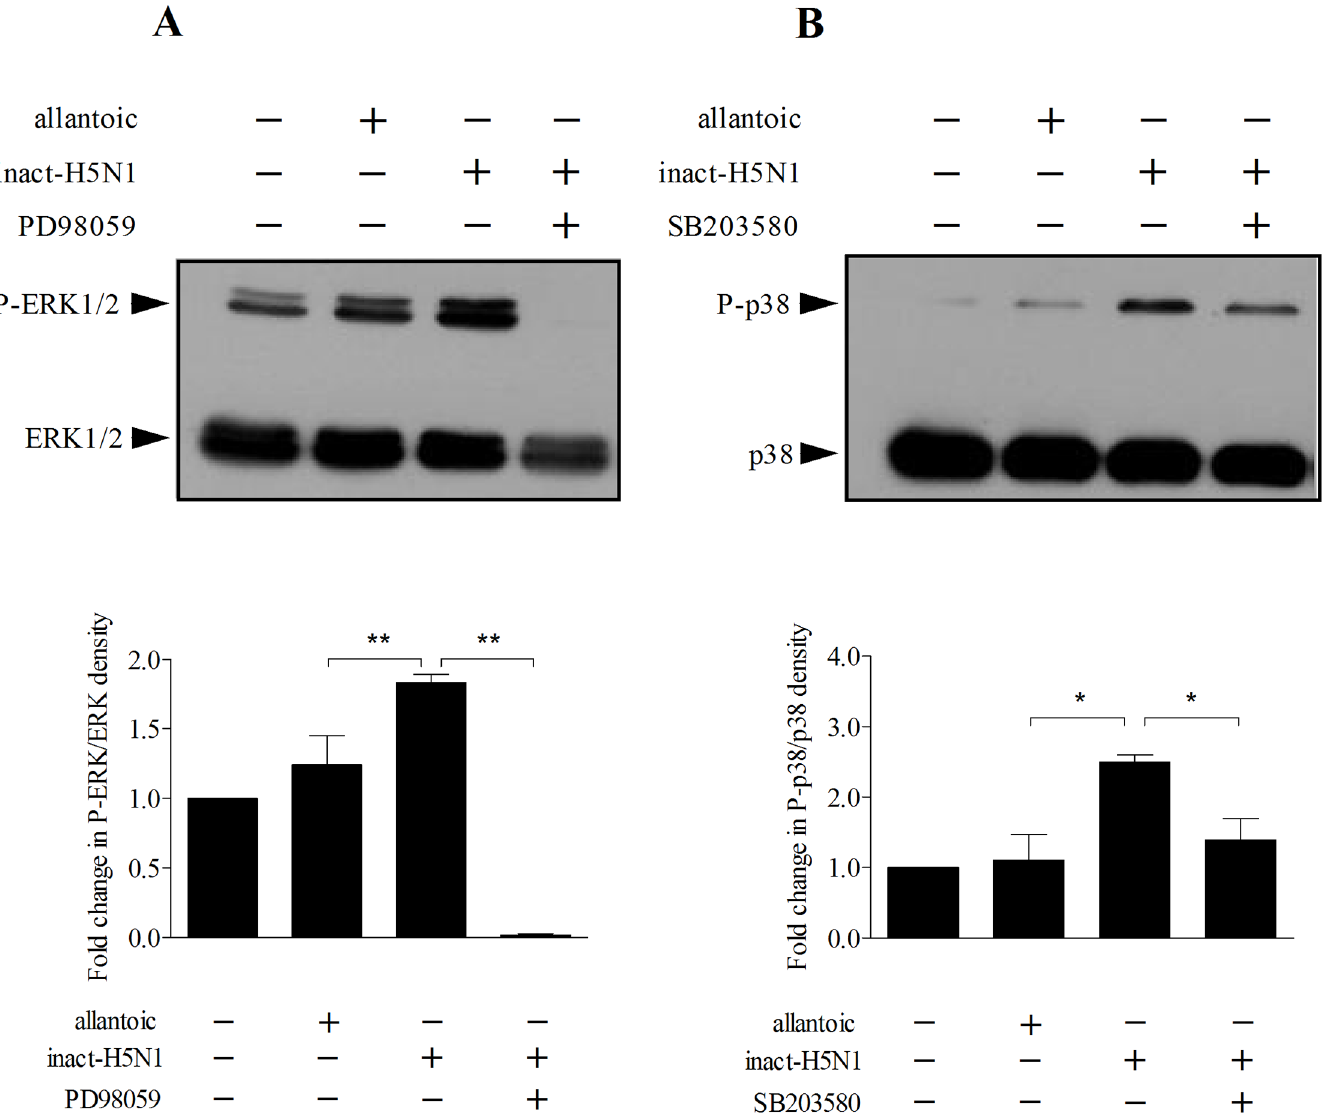
Fig 5. Inactivated-H5N1 increasesphosphorylation of ERK1/2 and p38 MAPK. Immunoblotanalysisof ERK1/2 (A) and p38 MAPK (B) protein expressionin 16HBE14o- cells treated with inactivated-H5N1. Cells were untreatedor treated with PD98059(50 μ M) or SB203580(10 μ M) as appropriate. One hour later, cells were treated for 30 min with vehicle, allantoicfluid or inactivated-H5N1 before being harvestedfor immunoblot analysisfor the presenceof ERK1/2, phospho-ERK1/2 (P-ERK1/2), p38 MAPK or phospho-p38MAPK (P-p38). Upper panel,representative gels for immunoblot analysis of ERK1/2 and phosphorylated ERK1/2 (P-ERK1/2) (A) or p38 MAPK and phosphorylated p38 MAPK (P-p38) (B) . Lower panel, quantitative analysisof the amount of P-ERK1/2 ( A ) or P-p38 MAPK (B) , expressedas fold change,using ImageJ software (NIH). Values are means ± SEM from at least 3 sets of experiments. * and *** indicates p < 0.05 and p < 0.001, respectively(one-way ANOVA with Student-Newman-Keuls post-hoc test).